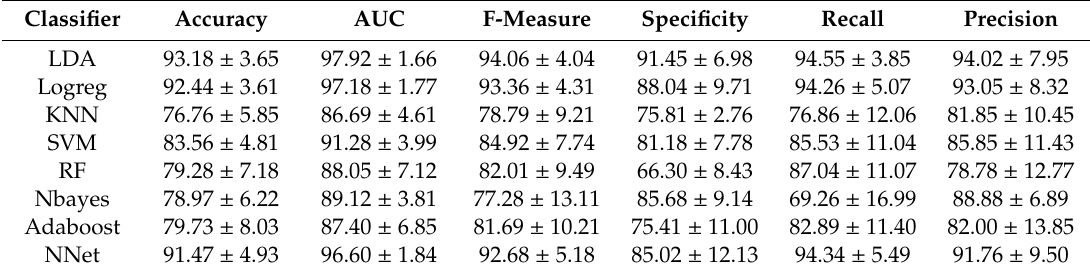
Table 3. Discriminant results by di ff erent classifiers using five-fold CV based on LA8 wavelet filter (mean ± standard deviation, %).